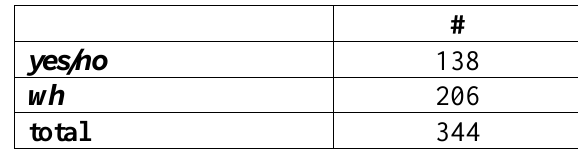
Table (2): Kinds of direct interrogatives